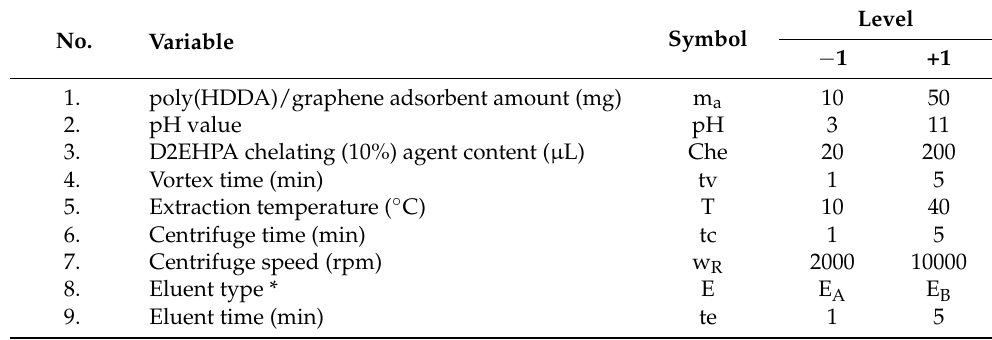
Table 1. The variables and their coded values ( − 1, +1) for the Plackett–Burman design.